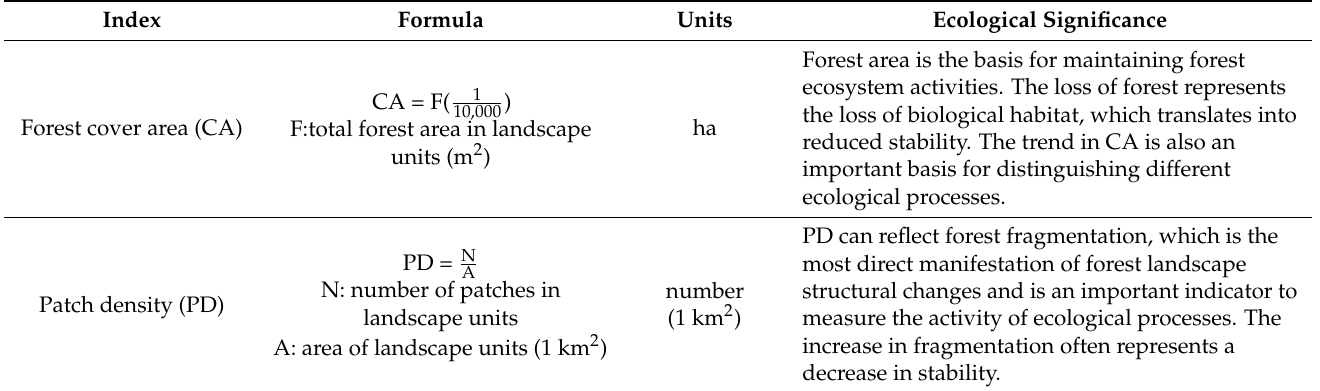
Table 1. Formulas for the representative landscape indices and their ecological